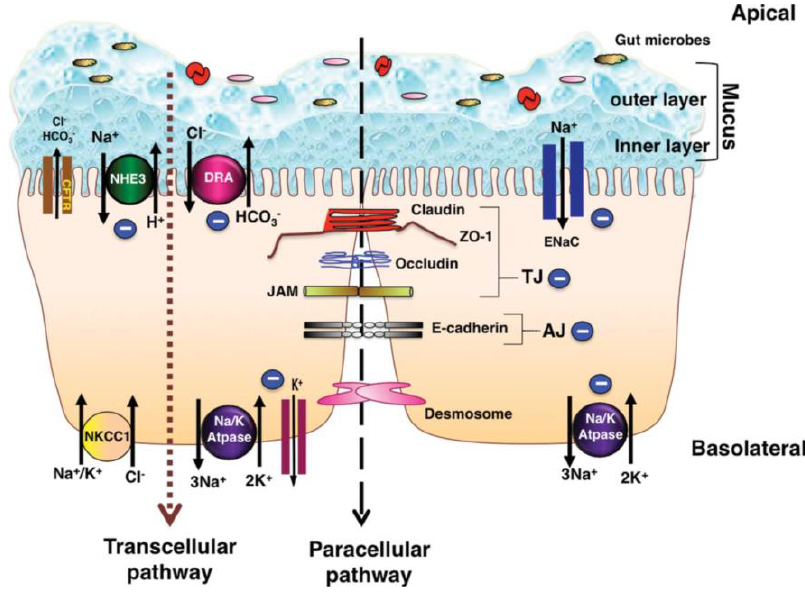
Figure 1. Schematic pathways of colonic ion transportation, adopted from Anbazhagan et al.